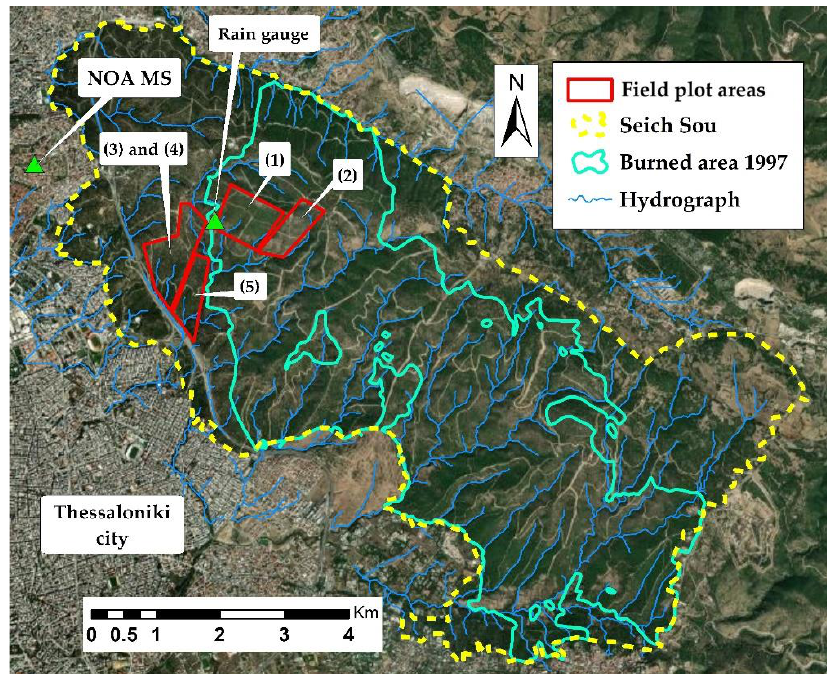
Figure 1. Study area. Thessaloniki suburban forest (Seich Sou). The red polygons depict the areas where the silt fences were installed; (1) areas naturally reforested after the wildfire of 1997, (2) areas characterized by reforestation failure, (3) areas infected by insects, (4) areas with insect outbreak and logging of dead trees, and (5) undisturbed areas as a control.